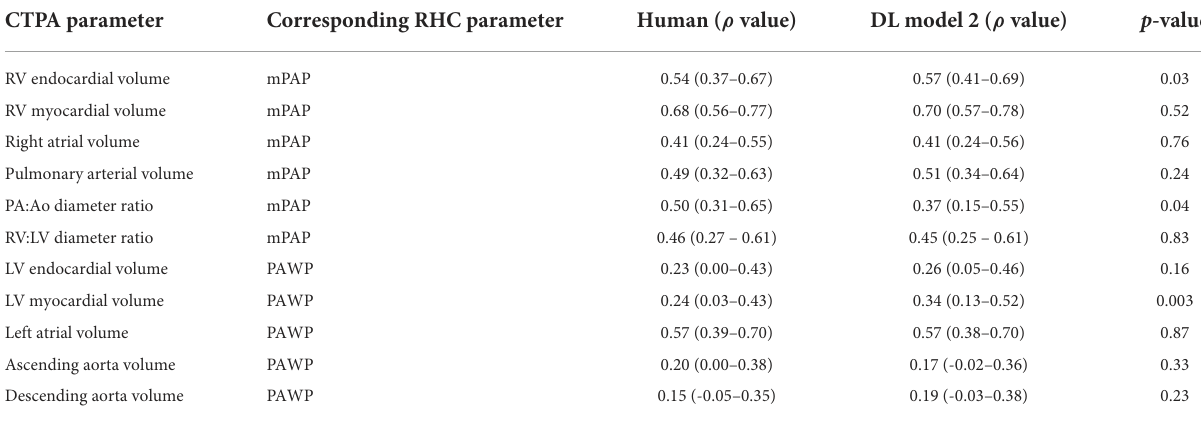
TABLE 7 Correlation between cardiac structure volumes and invasive haemodynamic measurements for human (observer 1) vs. DL model 2 in the internal test cohort ( n = 100). CTPA